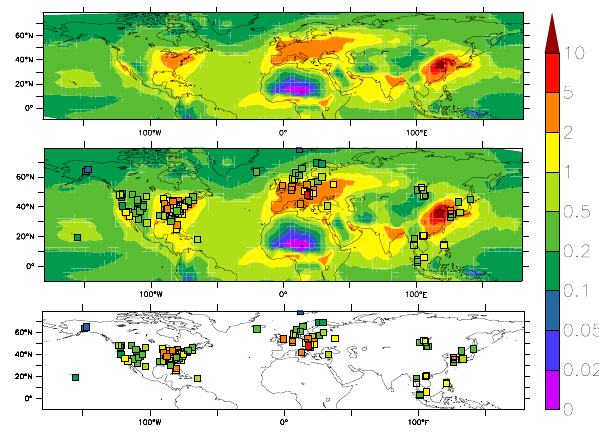
Fig. 11. Same as Fig. 9 but for nitrate aerosol (µg (NO 32 − )m − 3 ).